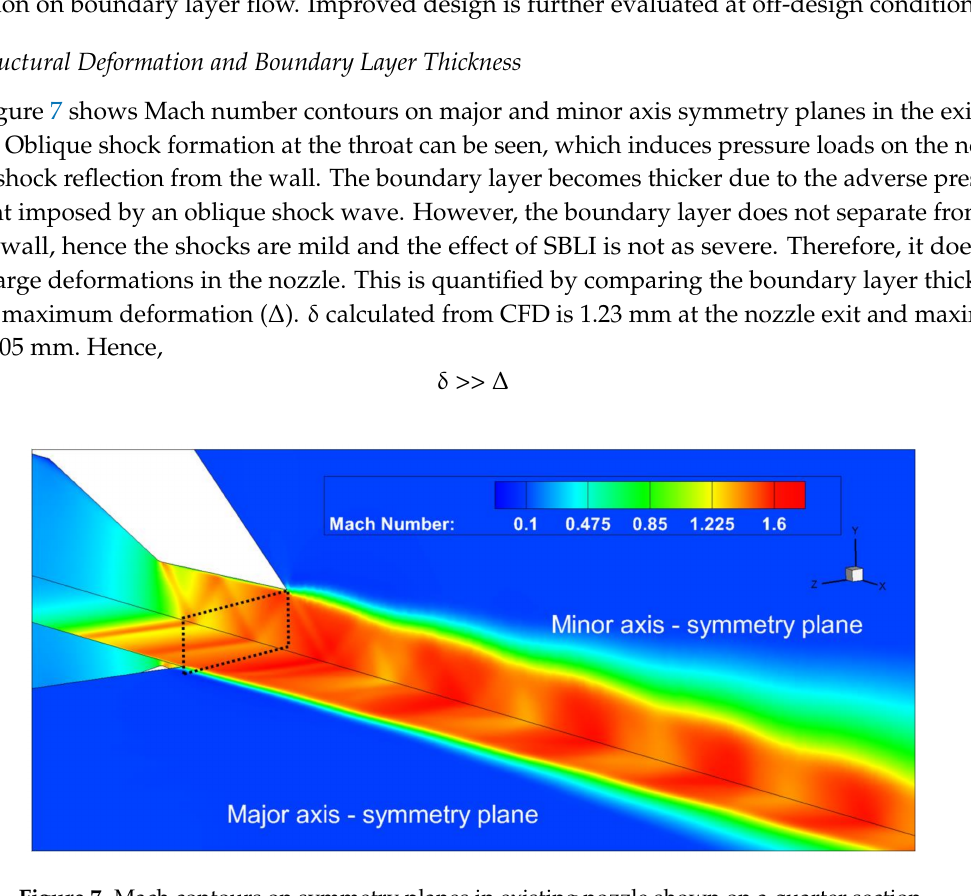
Figure 7. Mach contours on symmetry planes in existing nozzle shown on a quarter